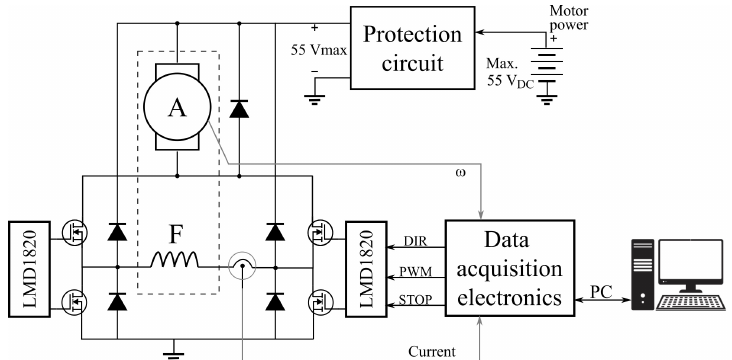
Figure 10. Power circuit to feed and invert the direction of the motor rotation.